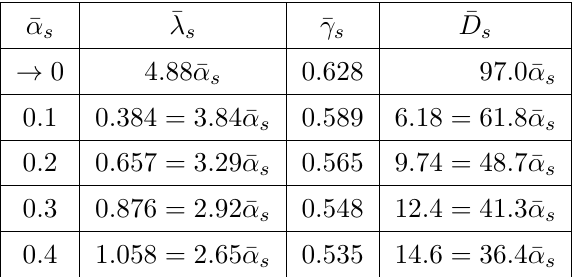
Table 1 . Asymptotic speed, slope and di(cid:11)usion coe(cid:14)cient for the non-local equation (6.1) for various values of the coupling constant (cid:22) (cid:11) s .